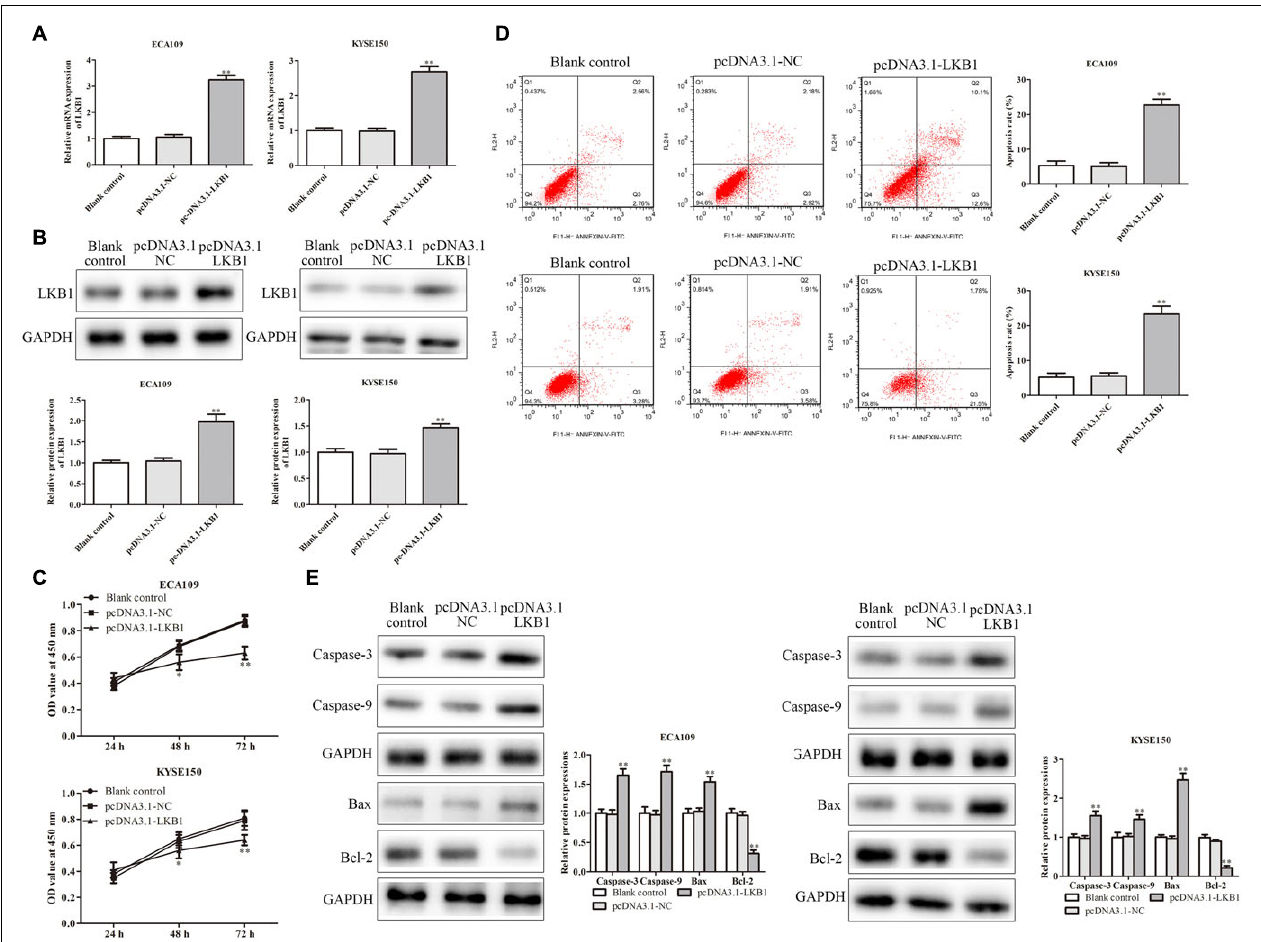
FIGURE 7 | LKB1 inhibited ESCC cell proliferation and promoted ESCC cell apoptosis. (A,B) The expression of LKB1 in ECA109 and KYSE150 cells transfected with pcDNA-LKB1 was examined by RT-PCR and western blotting assays, respectively. (C) Cell proliferation rates were examined by CCK-8 assay in ECA109 and KYSE150 cells. (D) The apoptosis rates of ECA109 and KYSE150 cells transfected with pcDNA-LKB1 were detected by flow cytometry. (E) The expression levels of caspase-3, caspase-9, Bax, and Bax-2 were analyzed in ECA109 and KYSE150 cells. GAPDH was used as a control. Bars indicate the mean ± SEM, * P < 0.05, ** P < 0.01 vs. control siRNA. LKB1, liver kinase B1; ESCC, esophageal squamous cell carcinoma; CCK-8, Cell Counting